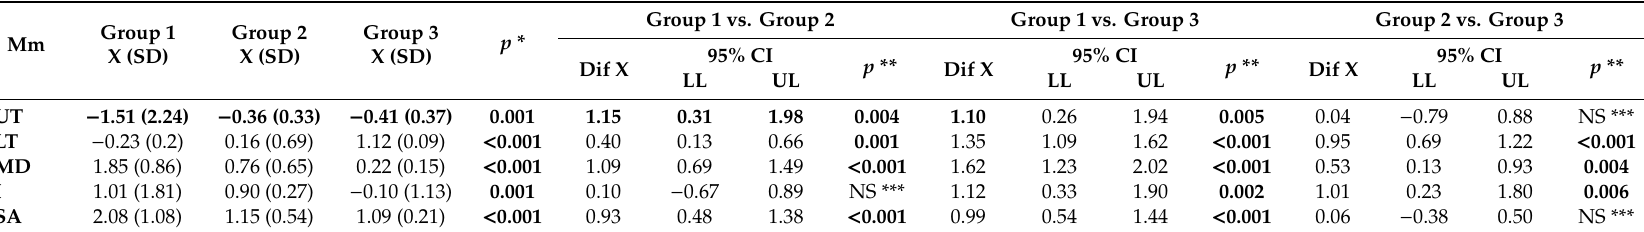
Table 2. The onset of muscle activity. Abduction movement.